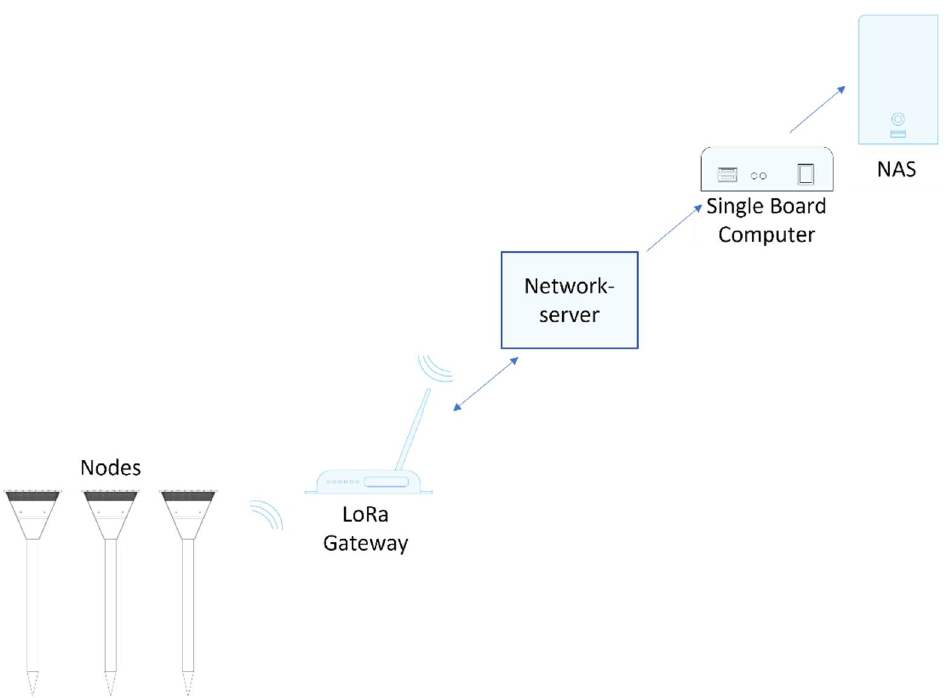
Figure 1. Structure of the LoRa wireless sensor network within this study. Data transfer from LoRa sensor nodes to LoRa Gateway happened wirelessly. The gateway as well as the single-board computer and the network-attached storage were connected via ethernet cable to the Internet.